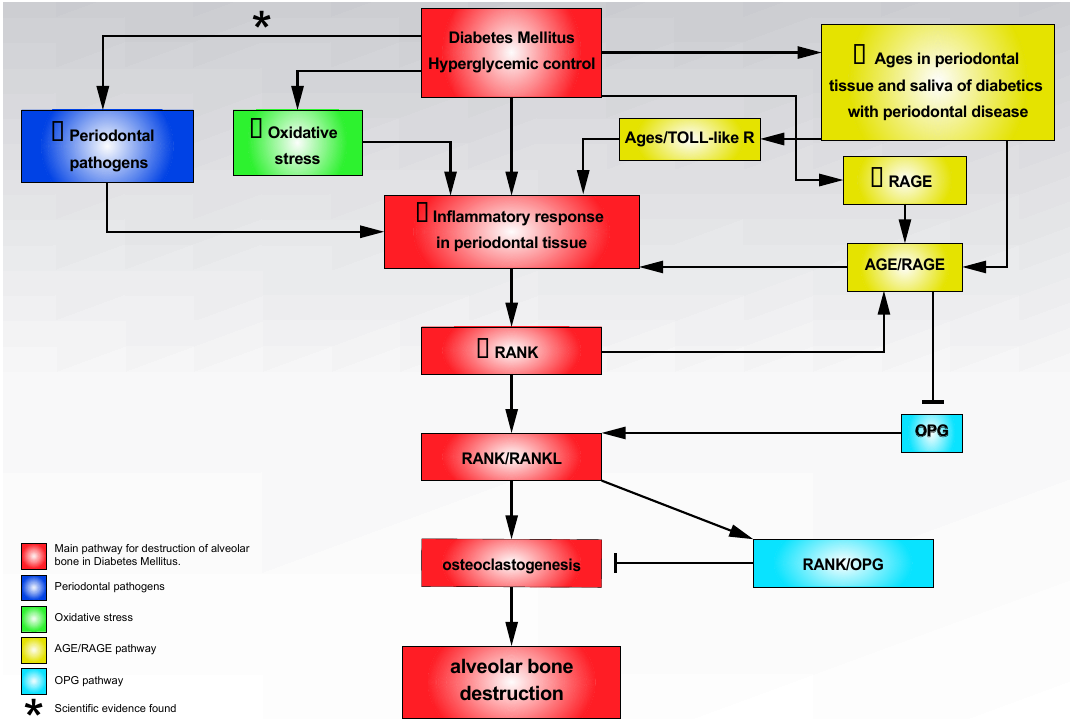
Figure 1. Diabetes Mellitus with a poor control generates sustained hyperglycemia, which in turn induces an increase in the inflammatory response in the periodontal tissue; this in turn stimulates the RANK/RANKL axis with an increase in osteoclastogenesis and destruction of the alveolar bone, which will conclude with the loss of teeth — one of the hallmarks in periodontitis. The increase in the number of periodontal pathogens, the increase in reactive oxygen species (ROS), and the increase in the expression of role of advanced glycation end products (AGE) and its receptor (RAGE) also activate the inflammatory response in the periodontal tissue. The receptor activator of nuclear factor κ B (RANK)/RANK-Ligand (RANKL)-RANK/osteoprotegerin (OPG) balance will be important in maintaining periodontal bone homeostasis.